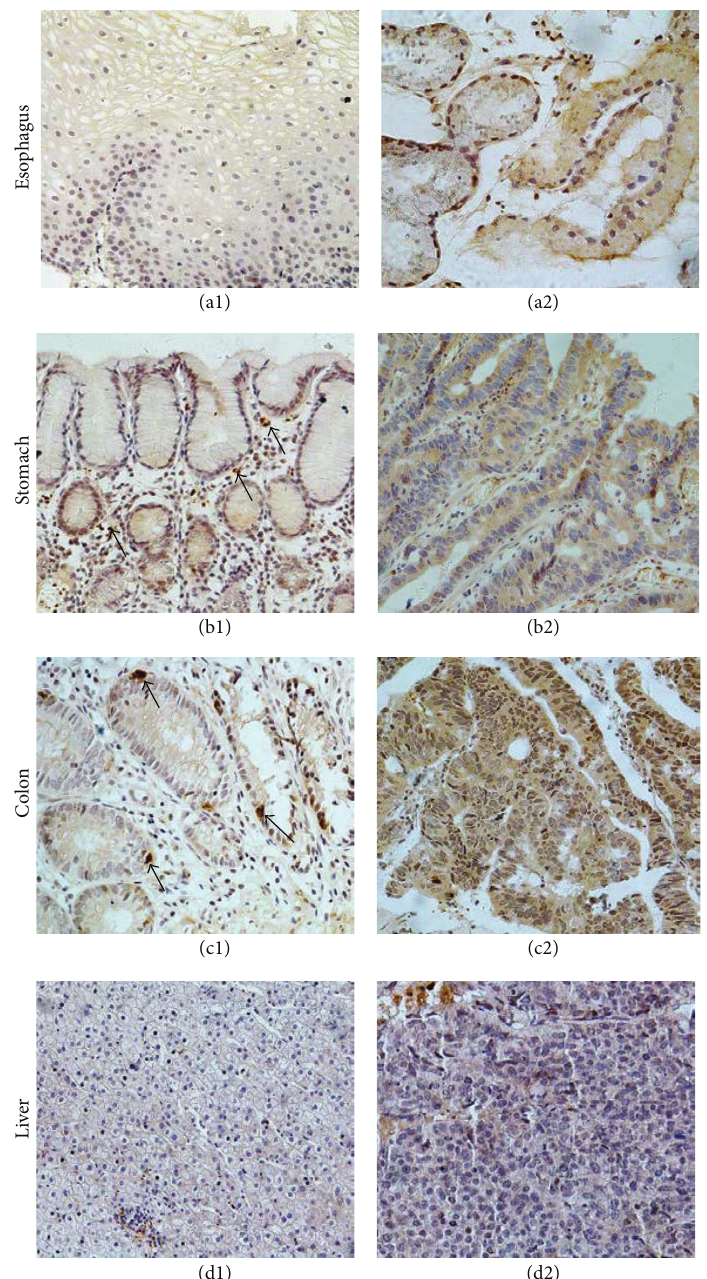
Figure 2: DUOX2 detected by IHC in different tissues of esophagus, stomach, colon, and liver. In normal epithelium of esophagus DUOX2 protein was not detected by IHC (a1); in the columnar epithelium of Barrett esophagus the expression of DUOX2 was mainly located in the apical membrane of epithelial cell (a2); in adjacent nonmalignant gastric tissue epithelial cells were stained negatively with DUOX2 antibody; some unidentified cells were stained positively in lamina propria (b1, arrows); in gastric cancer DUOX2 was mainly found in cell plasma of tumor cells (b2); DUOX2 was at a low level and was mainly at the edge brush of epithelial cells, endocrine cells were strongly stained for DUOX2 (c1, arrows), and DUOX2 expression was higher in CRC; there were nuclei stained with DUOX2 antibody (c2). In hepatic carcinoma and its adjacent nonmalignant tissue there was no DUOX2 IHC staining (d1 and d2). Magnification: ×